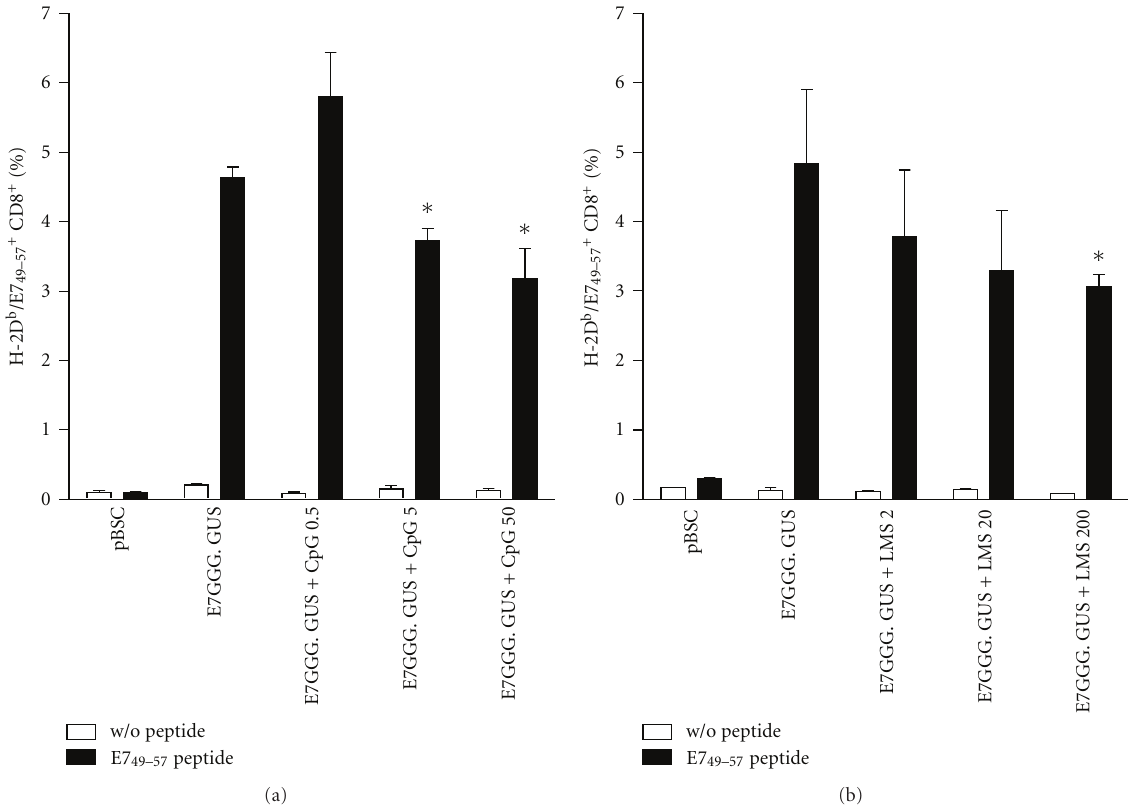
Figure 2: Detection of E7-specific splenic CTLs after DNA vaccination combined with systemic administration of adjuvants. C57BL/6 mice ( n = 3) were twice immunized at a 1-week interval with 1 μ g of pBSC or pBSC/E7GGG. GUS by a gene gun and i.p. injected with indicated doses of CpG-ODN (a) or LMS (b). One week after the second immunization, lymphocyte bulk cultures were prepared from splenocytes, restimulated with the RAHYNIVTF peptide for 6 days, and stained with a mixture of H-2D b /E7 49 − 57 -PE tetramers and anti-mouse CD8a- FITC antibody. Control lymphocytes were cultured without the peptide. Columns: mean of duplicate samples; bars: ± SD; ∗ P < 0 . 05 (the comparison with the E7GGG.GUS